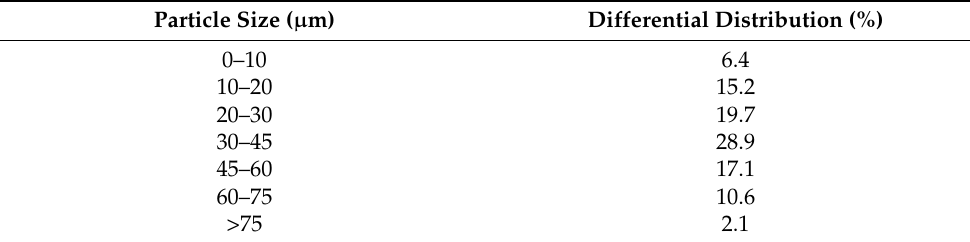
Table 3. Raw material particle size distribution.